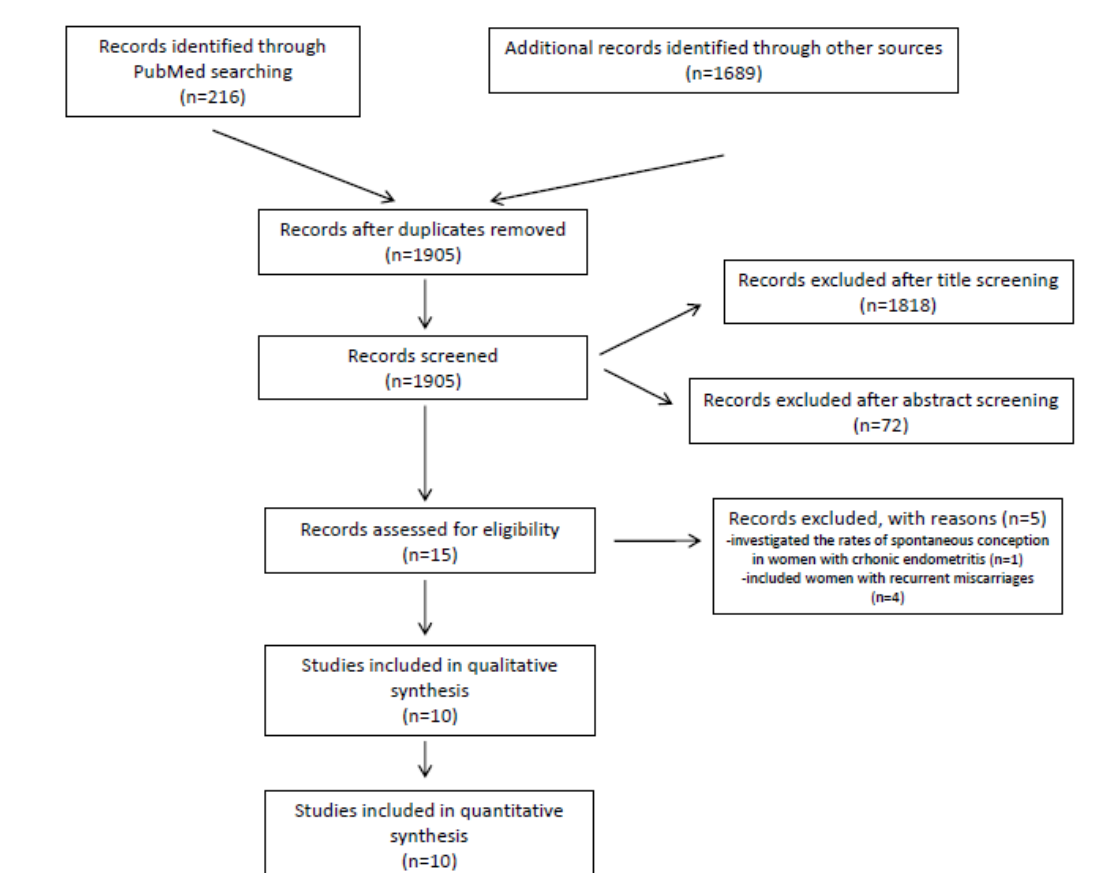
Figure 1. PRISMA flow-chart of study screening, selection, and inclusion/exclusion.